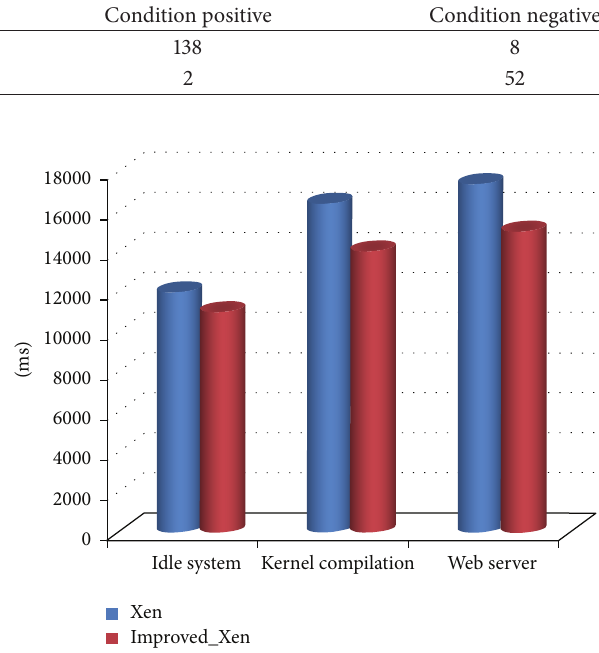
Figure 3: Comparison of dirty pages prediction using ARIMA model.